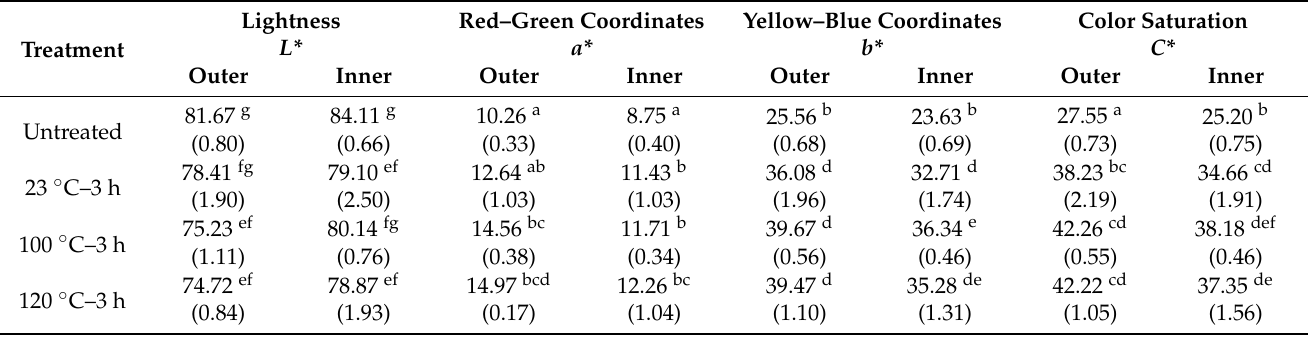
Table 1. The color of bamboo after tung oil treatment at different